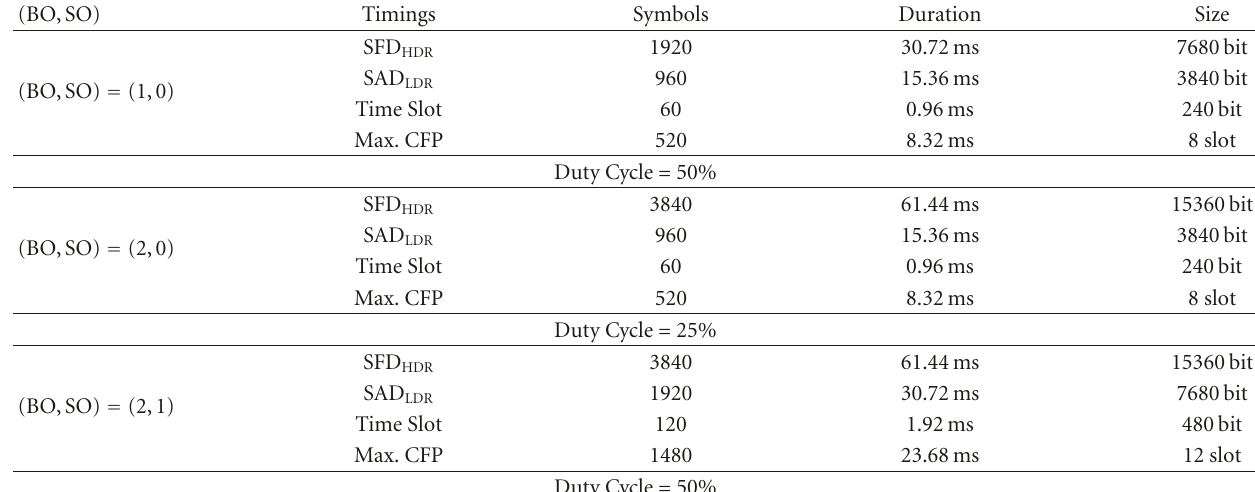
Table 3: 802.15.4 timings for a data rate of 250 kbps with AWA.